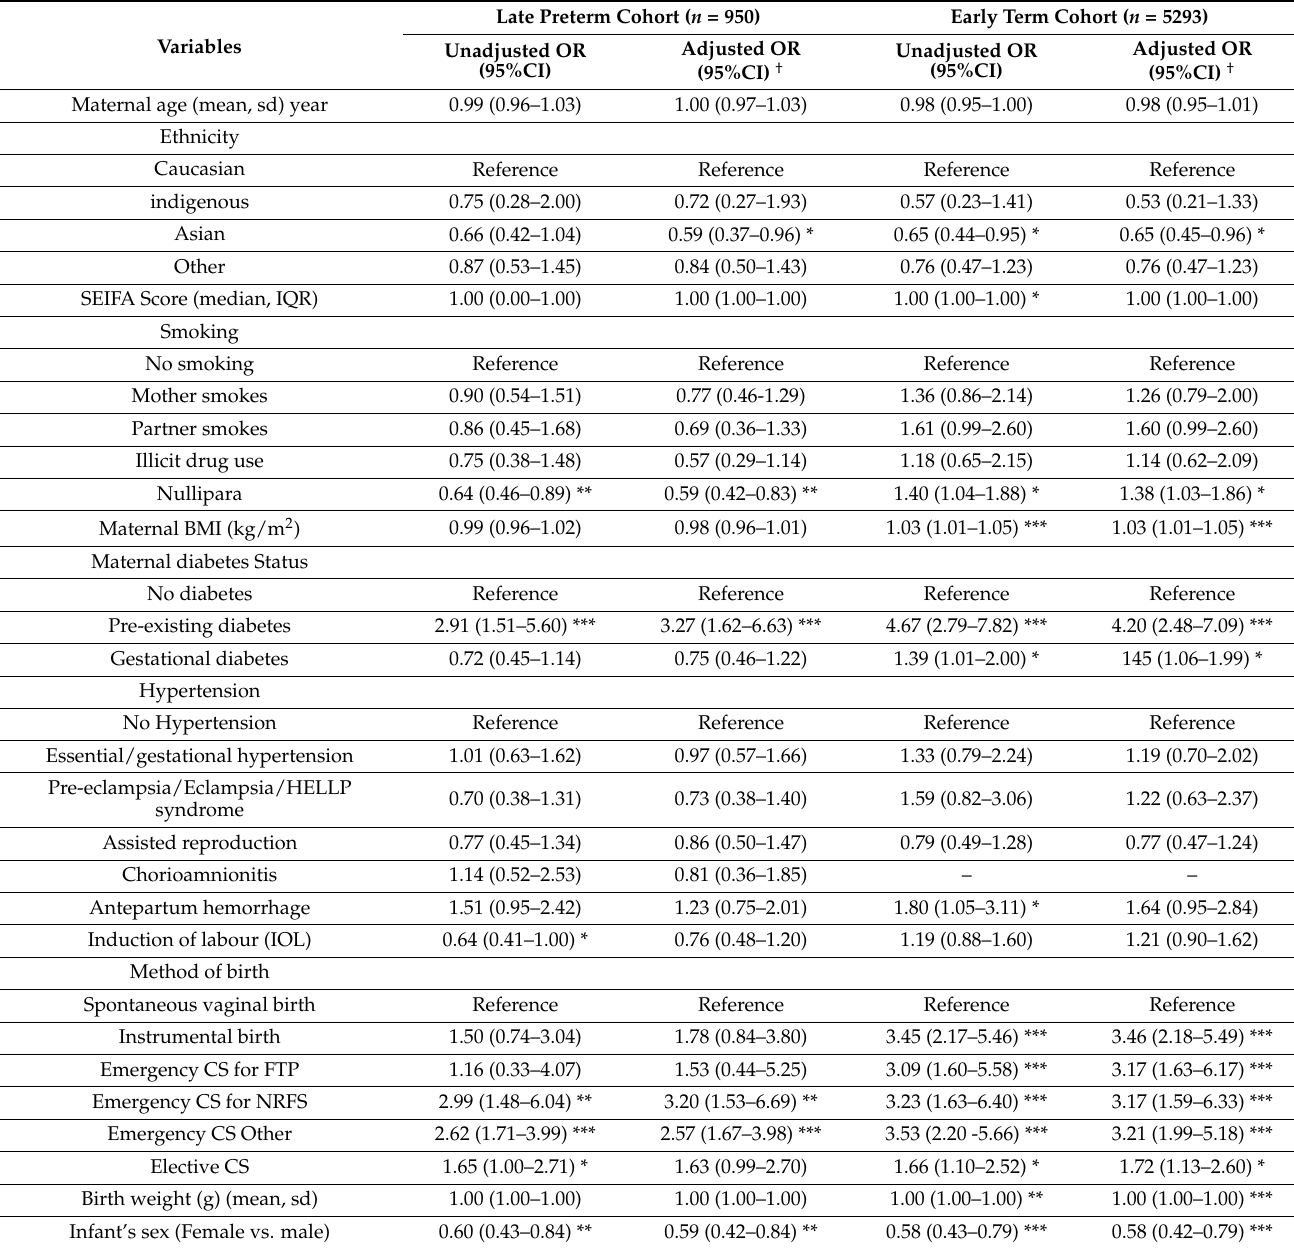
To assess the influence of gestational age at birth on early SNM in both cohorts, multivariable analyses adjusting only for gestational age was performed (Table 2). In the late preterm cohort, pre-existing diabetes (OR 3.27, 95%CI: 1.62–6.63), elective CS (OR 1.63, 95%CI: 1.00–2.70) and emergency CS for NRFS (OR 3.20, 95%CI: 1.53–6.69) were associated with increased odds of early SNM. Conversely, nulliparity (OR 0.59, 95%CI: 0.42–0.83), Asian ethnicity (OR 0.59, 95%CI: 0.37–0.96) and female sex (OR 0.59, 95%CI: 0.42–0.84) resulted in lower odds of SNM. Table 2. Unadjusted and gestational week adjusted association of risk factors and early severe neonatal morbidity (SNM) in late preterm and early term